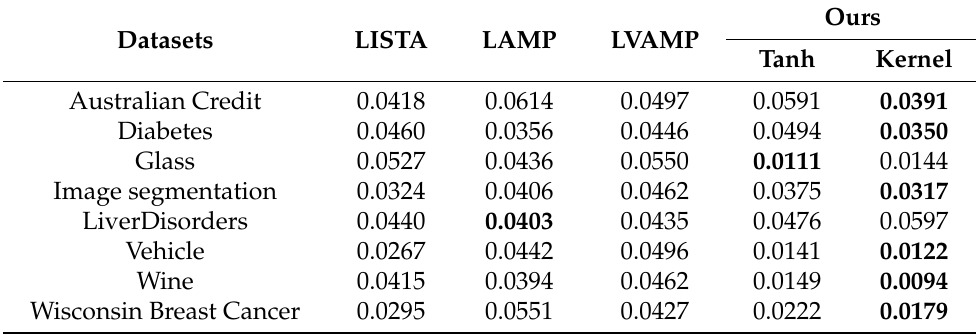
Table 2. The root mean square error of compared methods on UCI datasets (bold one represents the best